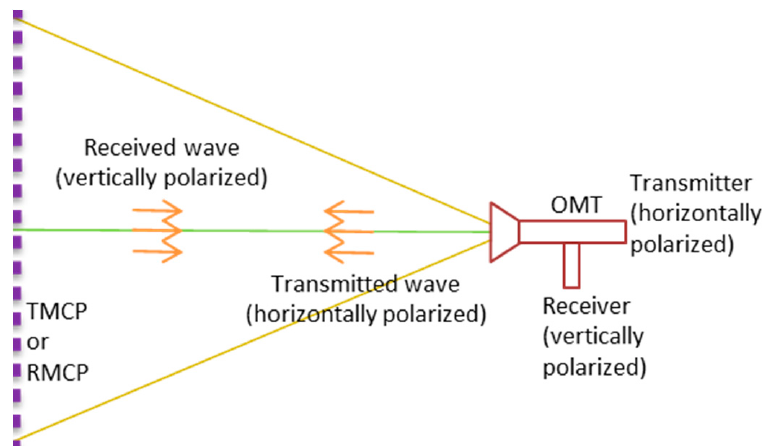
Figure 8. Feed systems using orthomode transducers (OMTs) instead of linear polarization (LP) filters for producing both vertical and horizontal polarizations from an antenna.